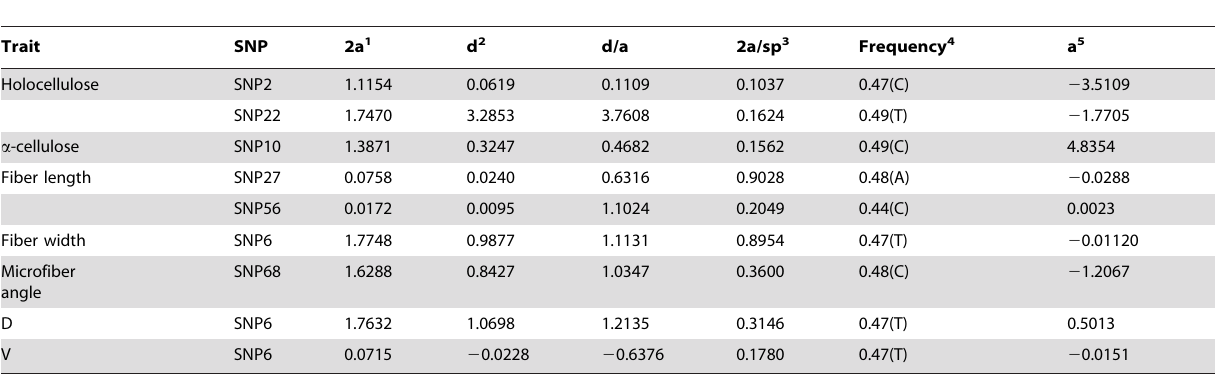
D = the diameter at breast height, V=stem volume. 1 Calculated as the difference between the phenotypic means observed within each homozygous class (2a=|G class). 2 Calculated as the difference between the phenotypic mean observed within the heterozygous class and the average phenotypic mean across both homozygous classes